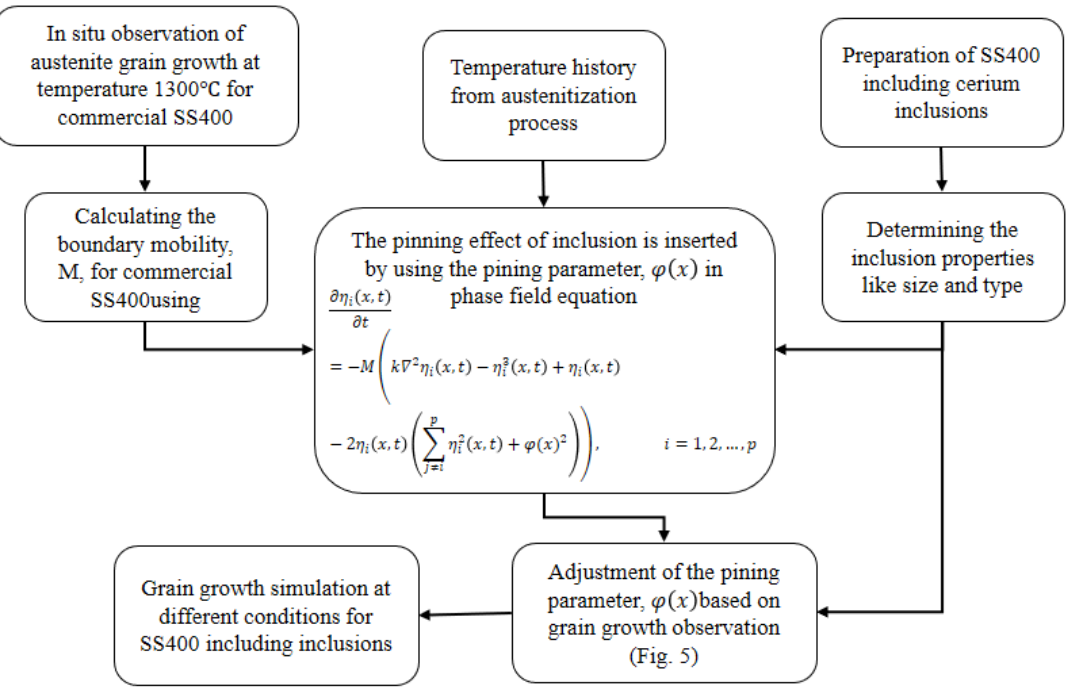
Figure 2. Schematic diagram of the pinning effect of inclusions in austenite grain growth in SS400 steel .